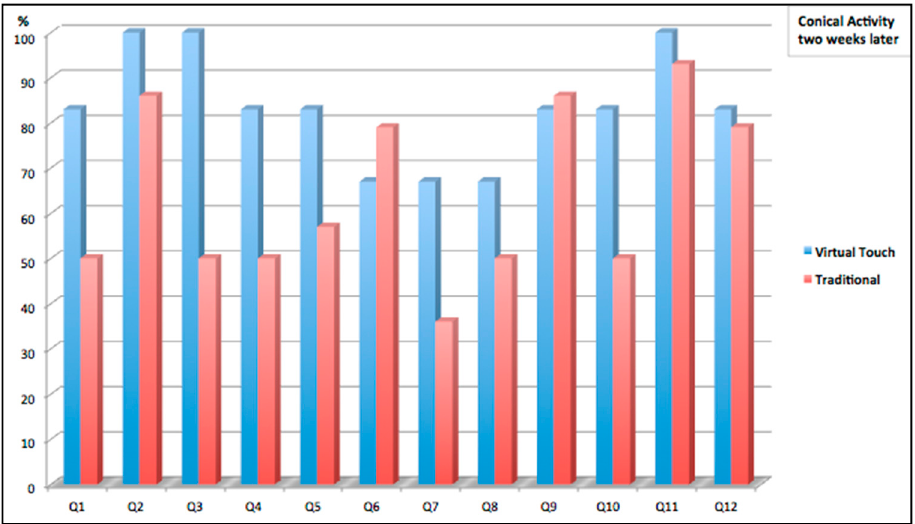
Figure 12. Comparative results: Virtual Touch and Traditional (two weeks later).